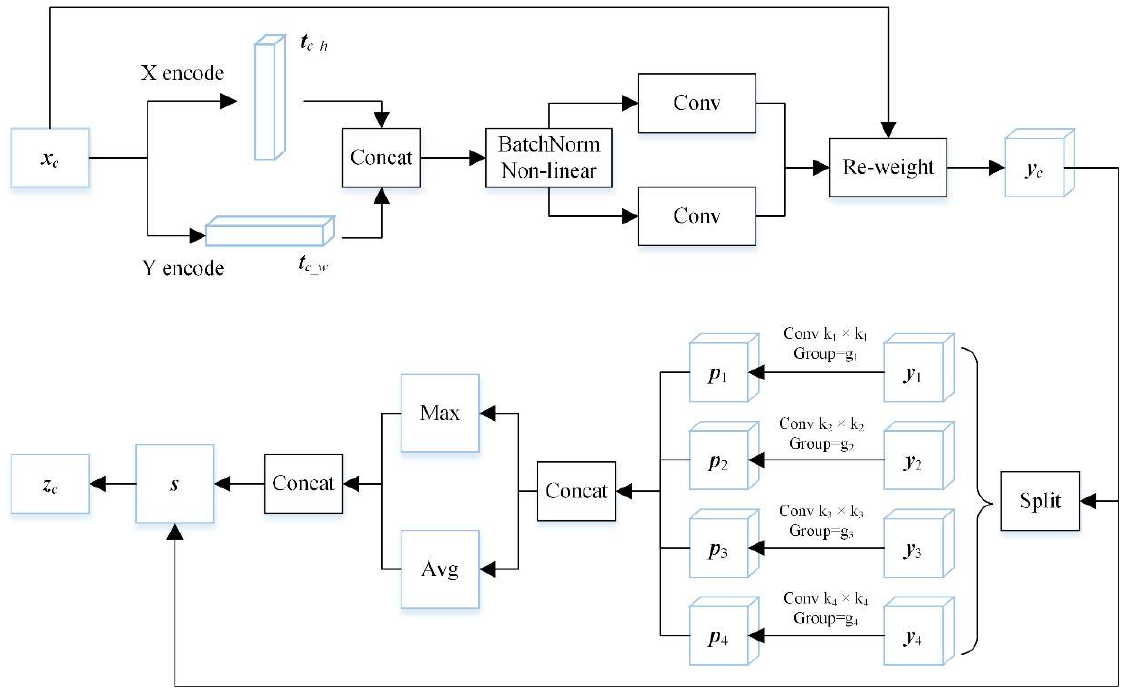
Figure 3. The structure of the spatial orientation attention module (SOAM). First, the input feature tensor X ∈ R C × H × W is subjected to one-dimensional adaptive average pooling along the horizontal and vertical directions to obtain two one-dimensional azimuth-aware tensors of the c -th channel, t c _ h and t c _ w . After features with precise encod- ing information in the X-direction and the Y-direction are obtained, they are concatenated together and then fed into 1 × 1 convolution to obtain intermediate features k